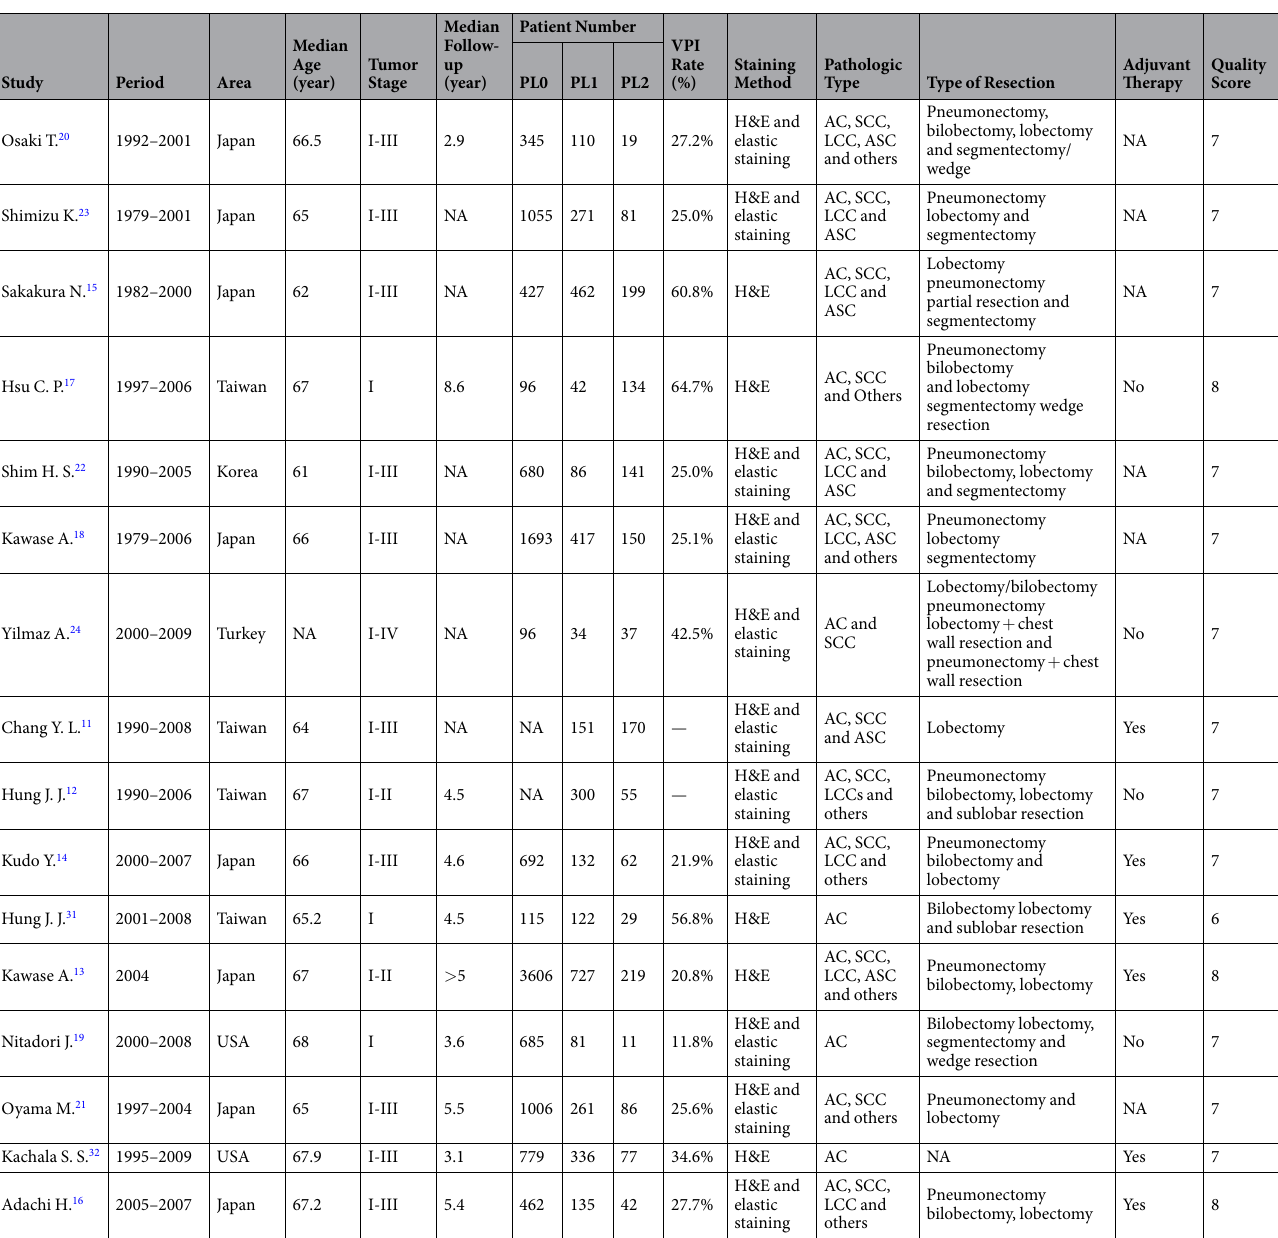
Table 1. Characteristics of included studies. * VPI: visceral pleural invasion; H&E: hematoxylin-eosin